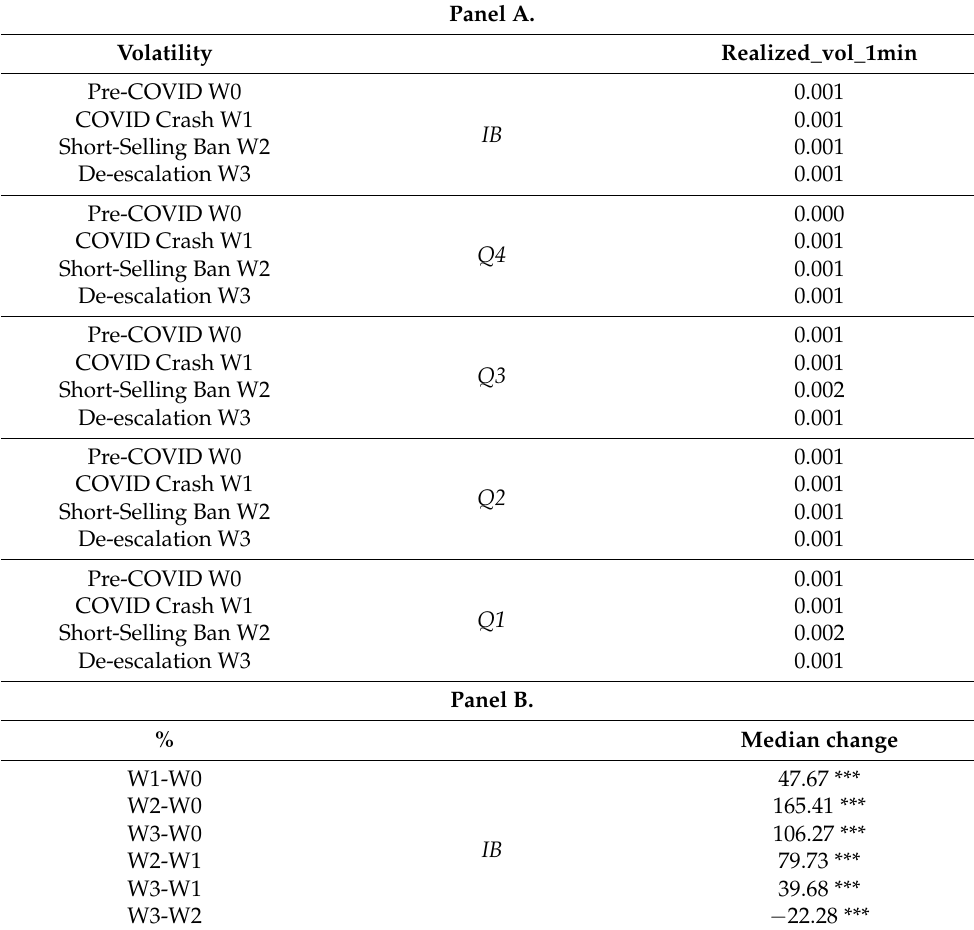
Table 4. Panel A. The 1 min realized volatility. Panel B. Changes in median: 1 min realized volatility. Panel